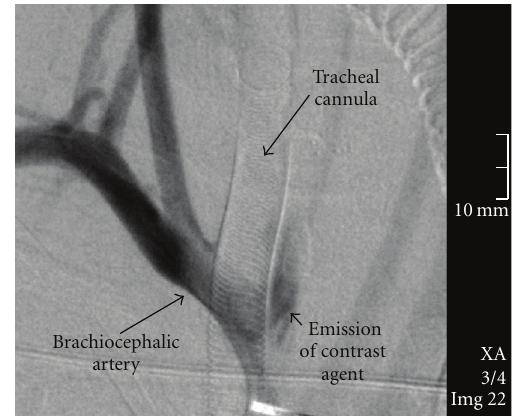
Figure 2: Angiographic scan (Case 2) of a free contrast agent beside the brachiocephalic artery at the level of the left lateral circumference of the tracheal cannula after slight tracheal cu ff